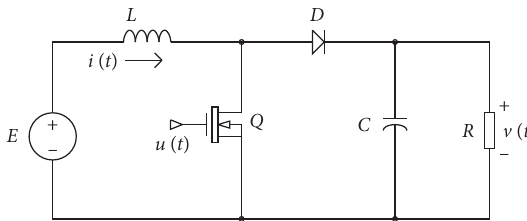
Figure 1: Electronic circuit of a boost power converter.